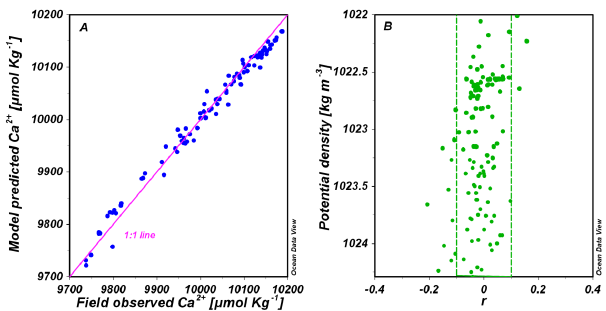
Fig. 7. (A) Scatter plot of the isopycnal mixing predicted Ca 2 + and the field observed Ca 2 + in the upper 100m of the central NSCS. (B) The individual error of the estimated Kuroshio water fraction ( r ) versus potential density in the upper 100m of the central South China Sea (SCS). Green lines donate the ± 0.1 range. Note that the analytical precision of Ca 2 + is better than ± 5µmolkg − 1 (Cao and Dai, 2011), which accounts for less than 2% of the estimated